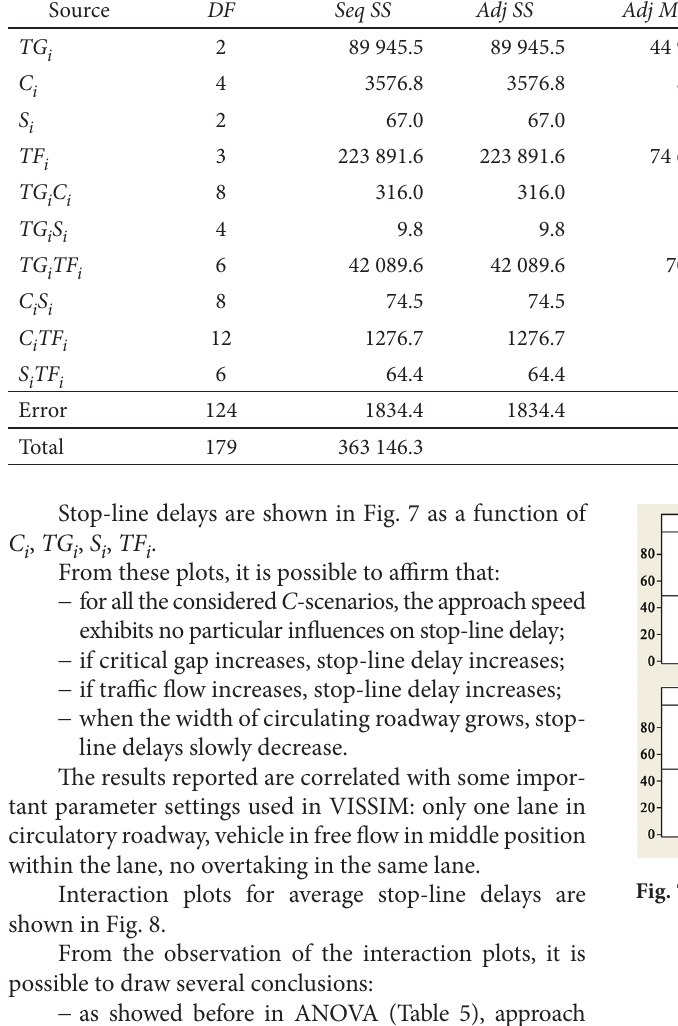
Table 5. Anova for stop-line delays in C -scenarios Source